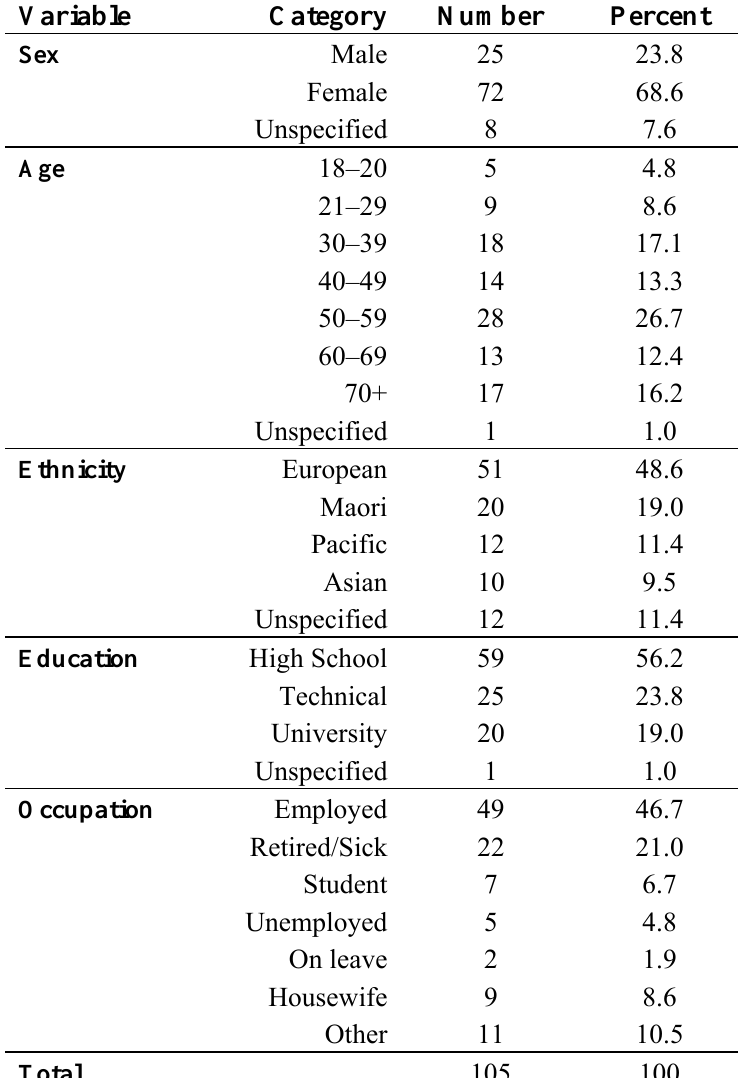
Table 1. Demographic characteristics of participants ( n =